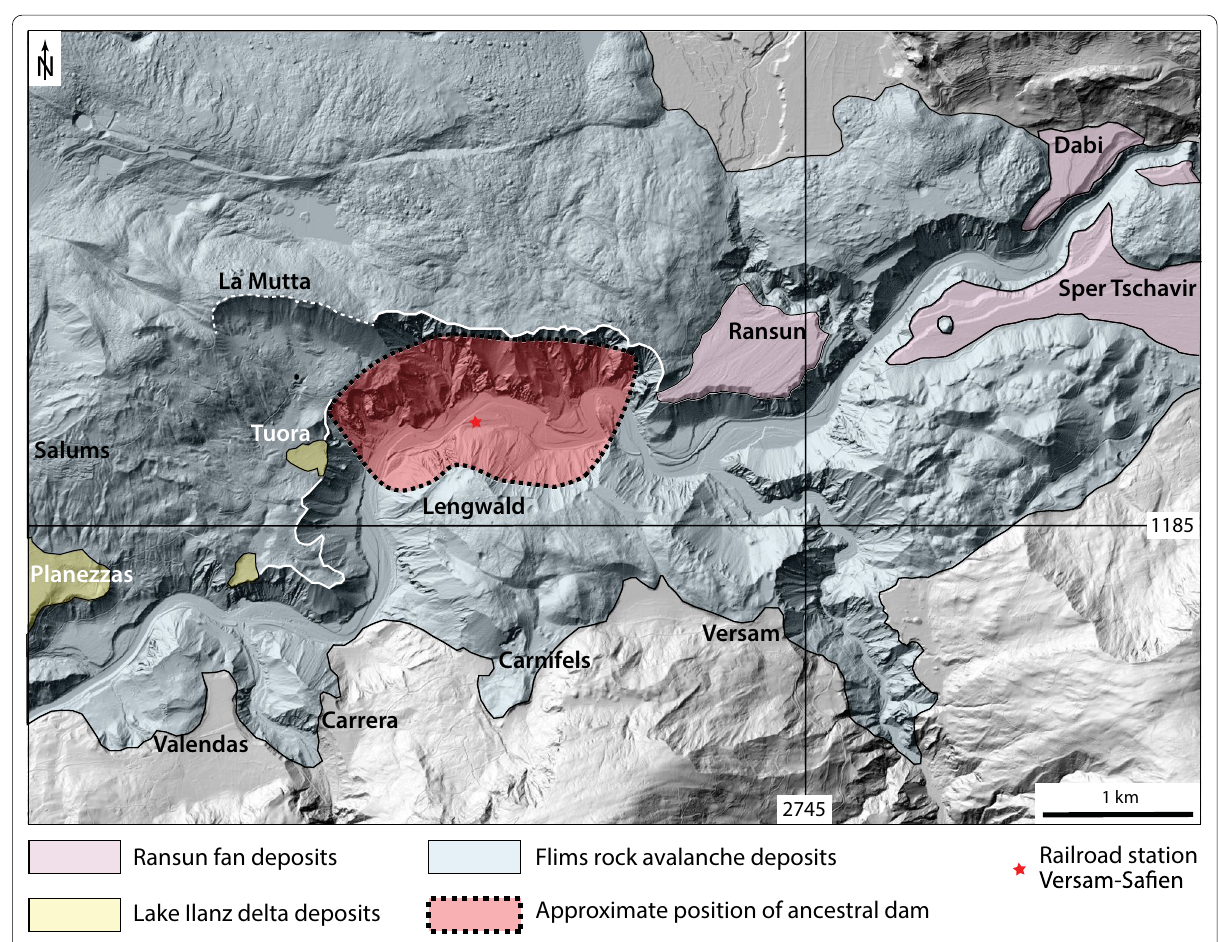
Fig. 15 Digital elevation model of the Ruinaulta (Vorderrhein). The most probable location of the ancestral dam extends in a E-W direction across the gorge. Three outcrops of delta deposits are found upstream of the dam at 820 m a.s.l. (Tuora and Planezzas) while the deposits of the Ransun fan downstream of the dam are located at less than 800 m a.s.l